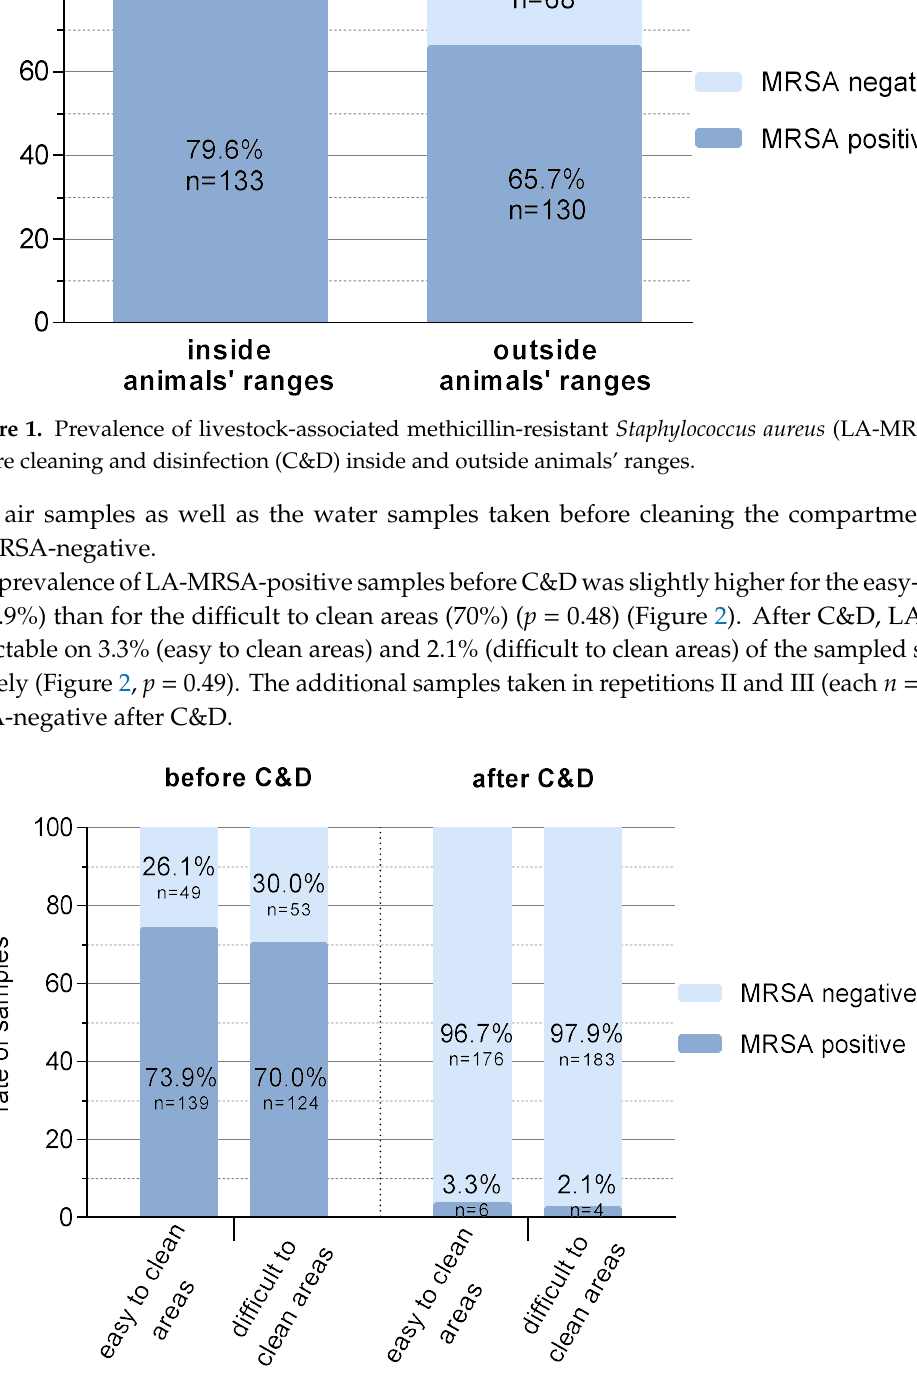
Figure 2. Prevalence of LA-MRSA before and after C&D depending on the difficulty of cleaning of the weaning pig compartments. Differences between easy and difficult to clean areas were not significant.